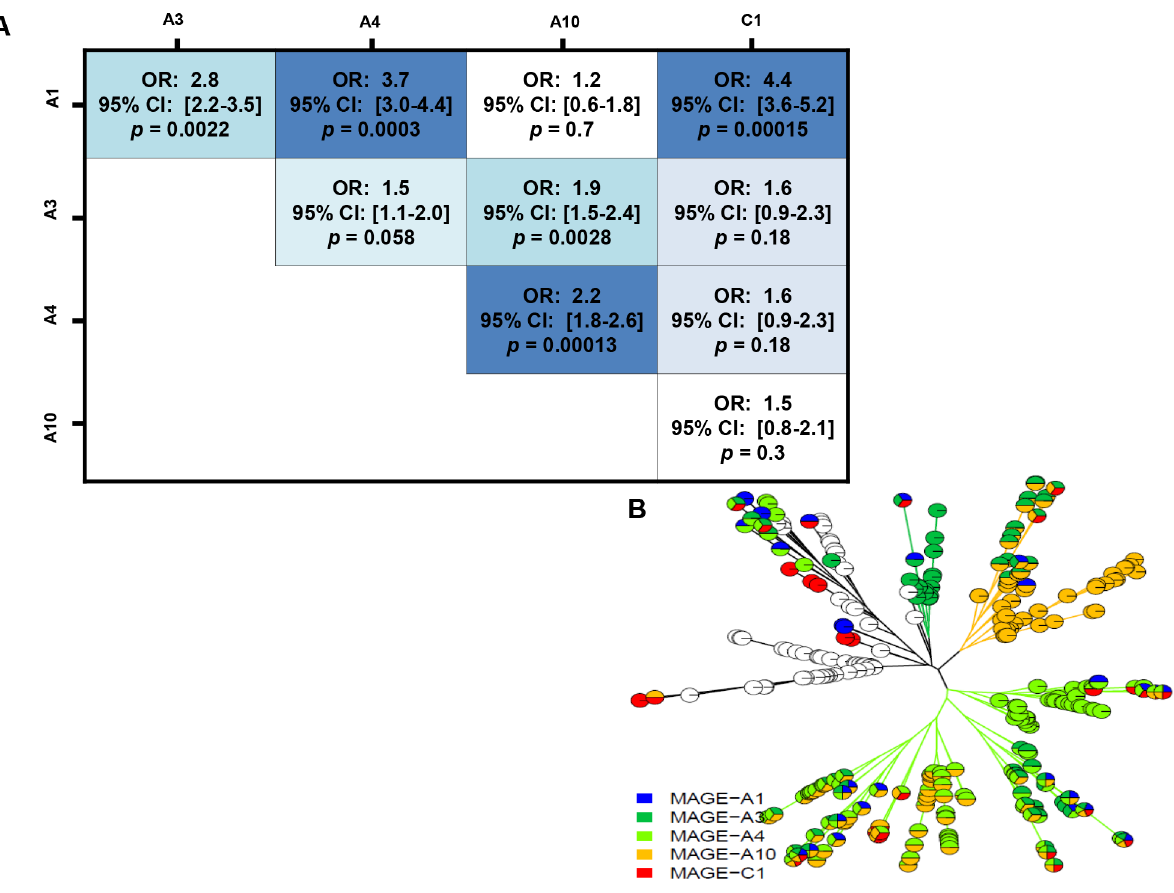
Figure 2. A–B: Co- expression of MAGE antigens in ovarian cancer. (A) MAGE-A1 is co-expressed with –A3 or –A4 or –C1. MAGE-A3 is co- expressed with –A10. MAGE-A4 is co-expressed with MAGE-A10. The darker color intensity represents a stronger significance. The strongest associations are between MAGE-A1 to –A4, MAGE-A1 to –C1 and MAGE-A1 to –A3. Odds ratios (OR) greater than 1 imply the antigens tend to appear together. (B) Phylogenetic tree for MAGE expression. Each leaf ending in a pie chart symbolizes a person.